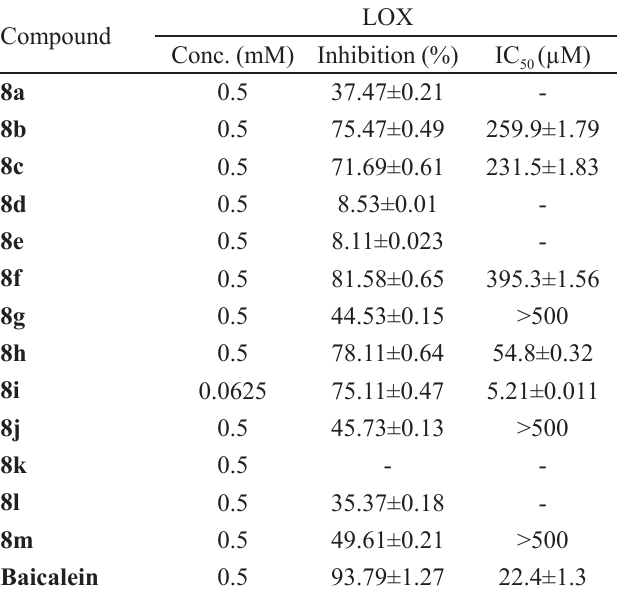
values of enzyme inhibition activity of the 50